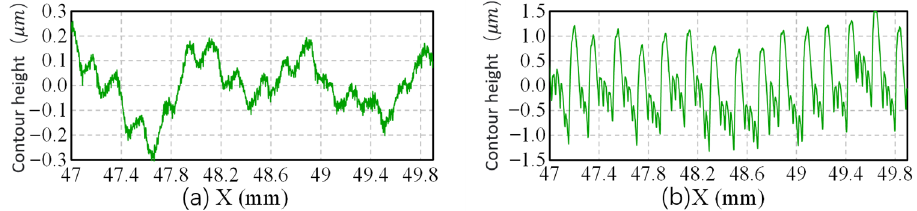
Figure 10. Low-speed profile of the fracture surface at the steady [21]. ( a ) Silicon layer; ( b ) glass layer.